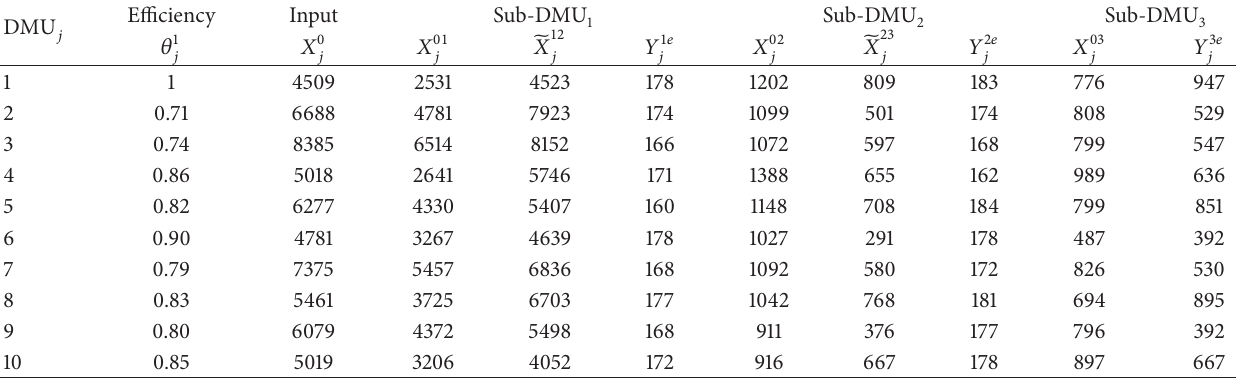
Table 4: Evaluation data of DN-DEA ( 𝑡 = 4 ).